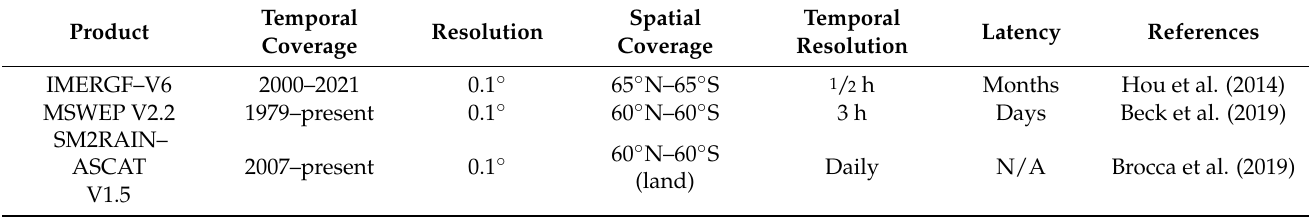
Table 1. Description of the SPPs chosen for this